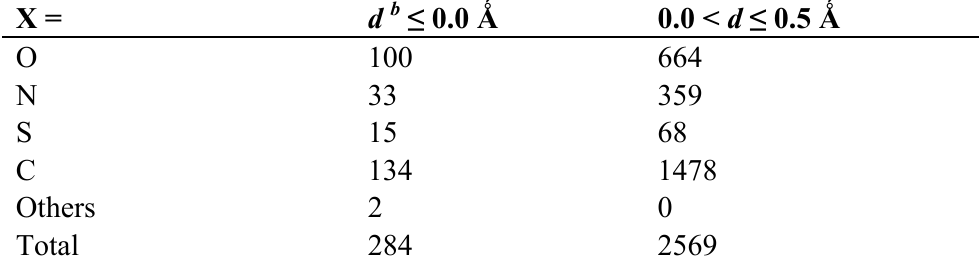
Table 1. Numbers of S(SSC)···X contacts in selected proteins [17] a